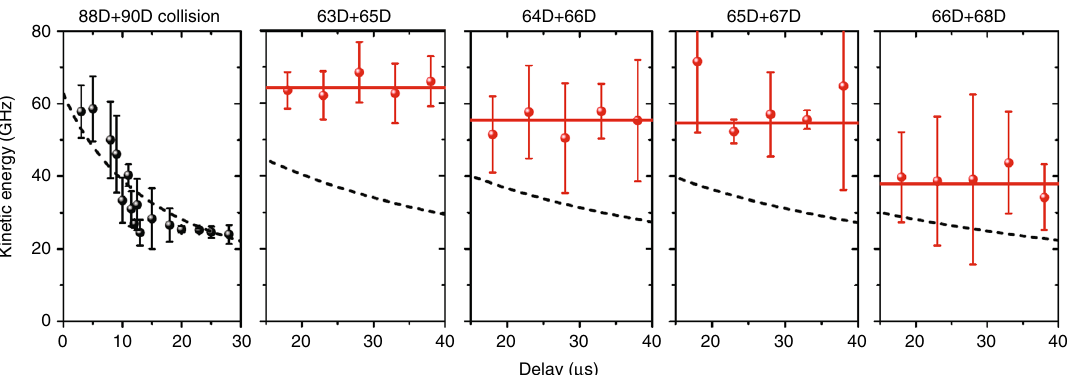
Fig. 5 Kinetic energy spectra from the fragmentation of macrodimers. The kinetic energy as a function of the delay, τ , between when a particular molecular complex was excited and when it was probed via fi eld ionization. In the leftmost panel a state correlating to 88 d + 90 d is fi rst excited. The other fi gures correspond to states correlating with 63 d + 65 d , 64 d + 66 d , 65 d + 67 d , and 66 d + 68 d . The dashed line in the leftmost panel shows the kinetic energy expected for a pair of Cs atoms photoassociated at R = 2.8 μ m and moving uniformly apart at a velocity of 17 cm s − 1 . The other four panels show the same quantity for macrodimer states for an electric fi eld of 224 mV cm − 1 for 63 d + 65 d , 205 mV cm − 1 for 64 d + 66 d , 190 mV cm − 1 for 65 d + 67 d and 158 mV cm − 1 for 66 d + 68 d . The red points are the data while the dashed line is what is expected for a laser induced collision of the pair of Cs atoms with a recoil energy equal to the thermal energy of the atoms in the ultracold atom trap. Figure from ref. 24 . Reprinted with permission from Nature Publishing Group